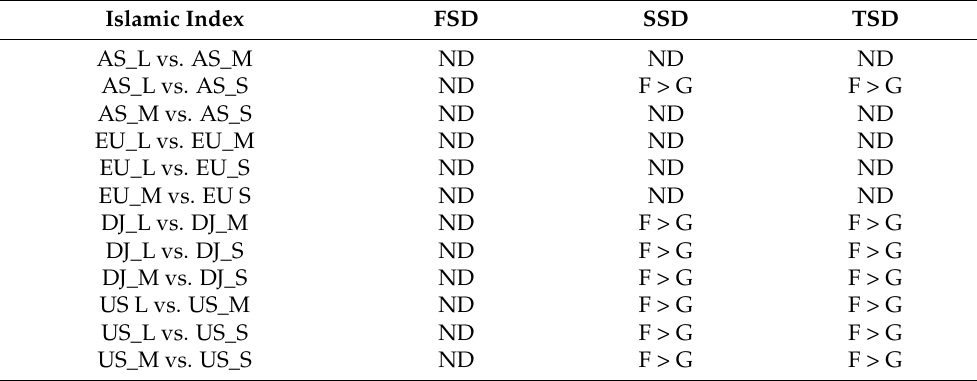
Table 4. Ascending Stochastic dominance (ASD) results of Davidson and Duclos test: sub-period 2